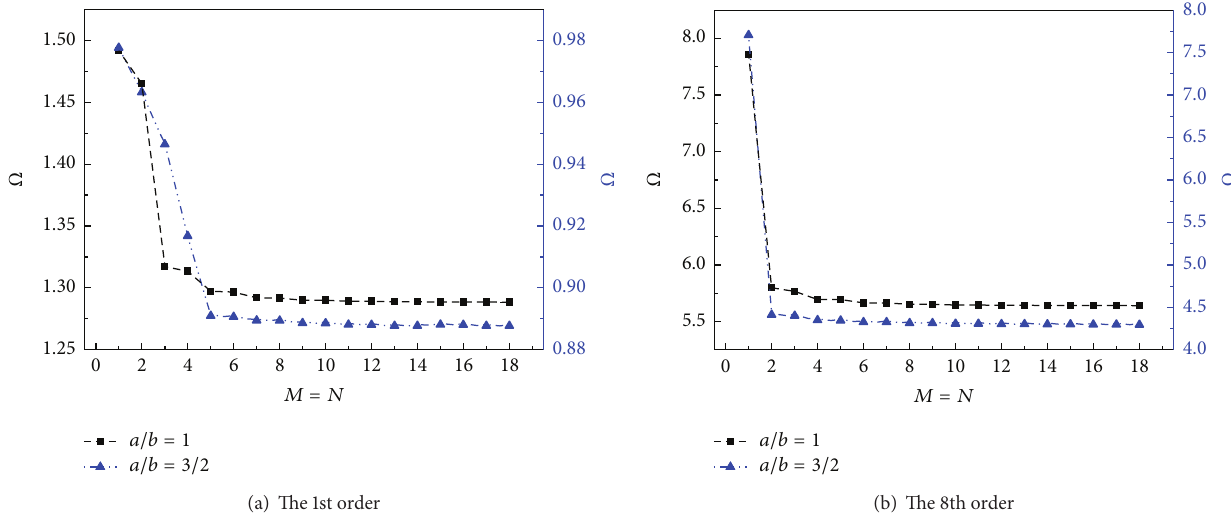
Figure 4: The effect of numerically truncated numbers 𝑀 = 𝑁 on the natural frequencies Ω for F-F-F-F boundary